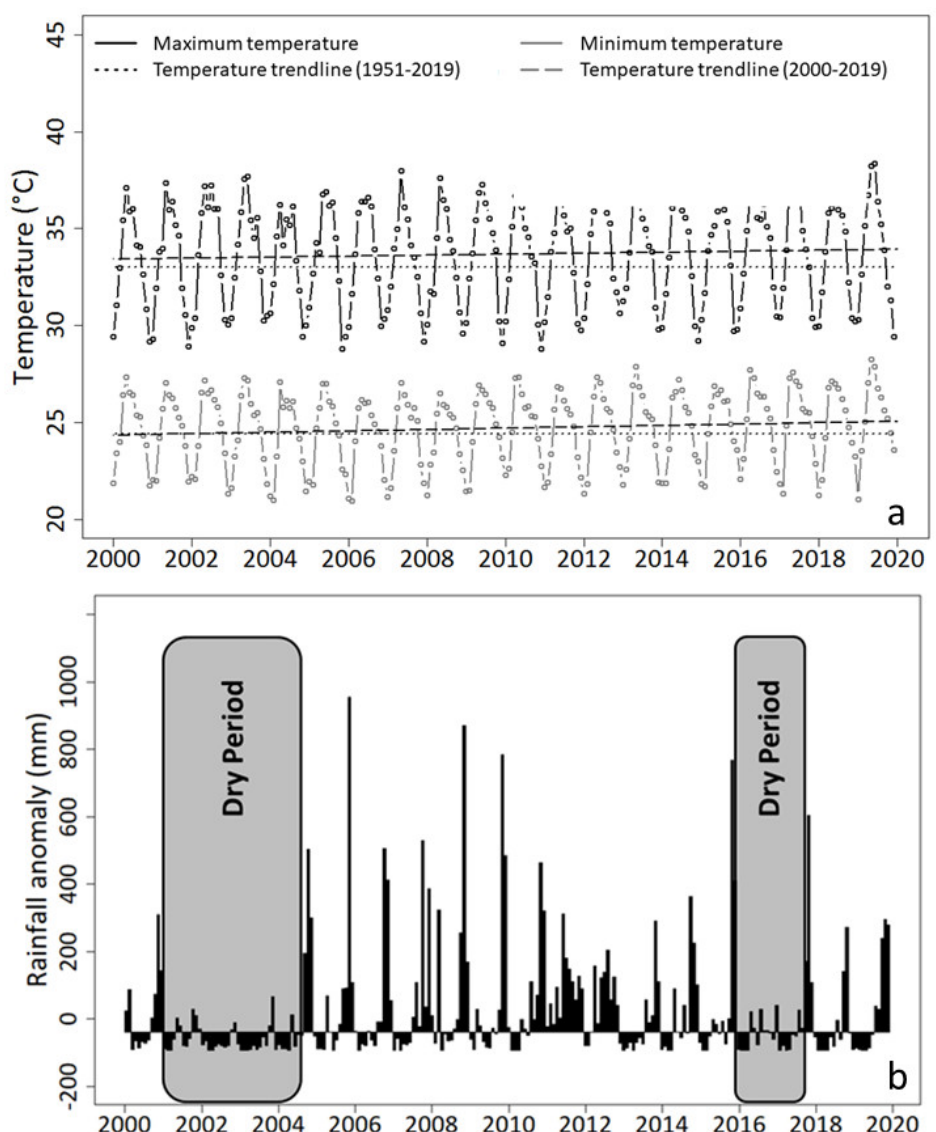
Figure 11. Air temperature for Cuddalore, near Pichavaram. Monthly maximum and minimum temperatures are provided for the time period of 2000−2019. Linear trends for both the 1951−2019 and 2000−2019 time periods are also indicated ( a ). Median rainfall anomalies for Pichavaram from 2000 to 2019 (encompassing the study period) are presented. Abnormal dry periods from 2001 to 2005 and from 2016 to 2017 are highlighted ( b ).